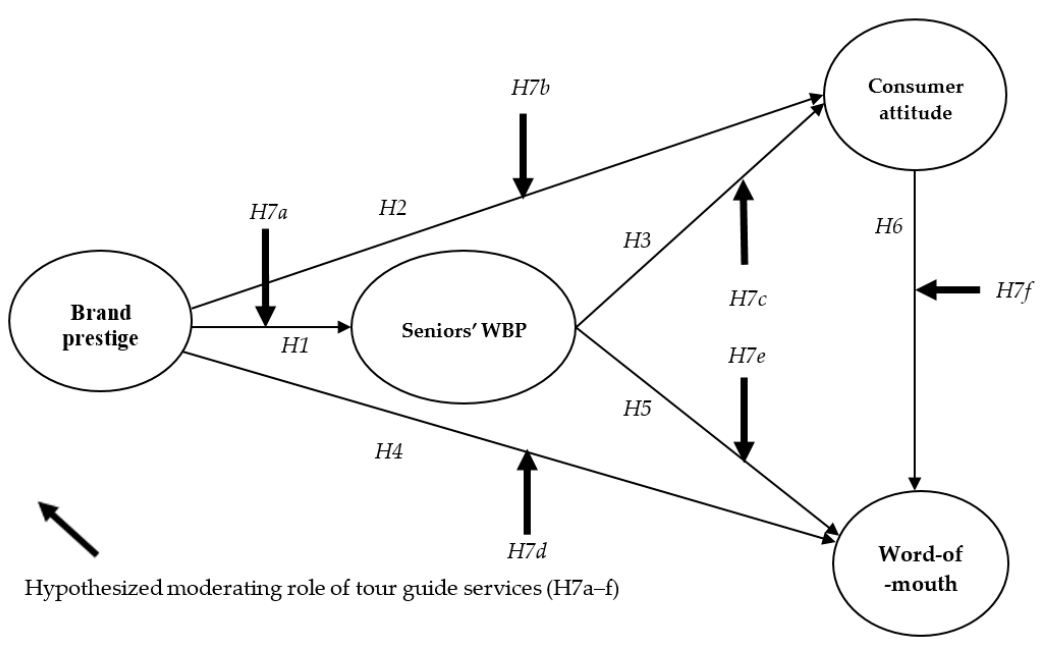
Figure 1. Proposed conceptual model.